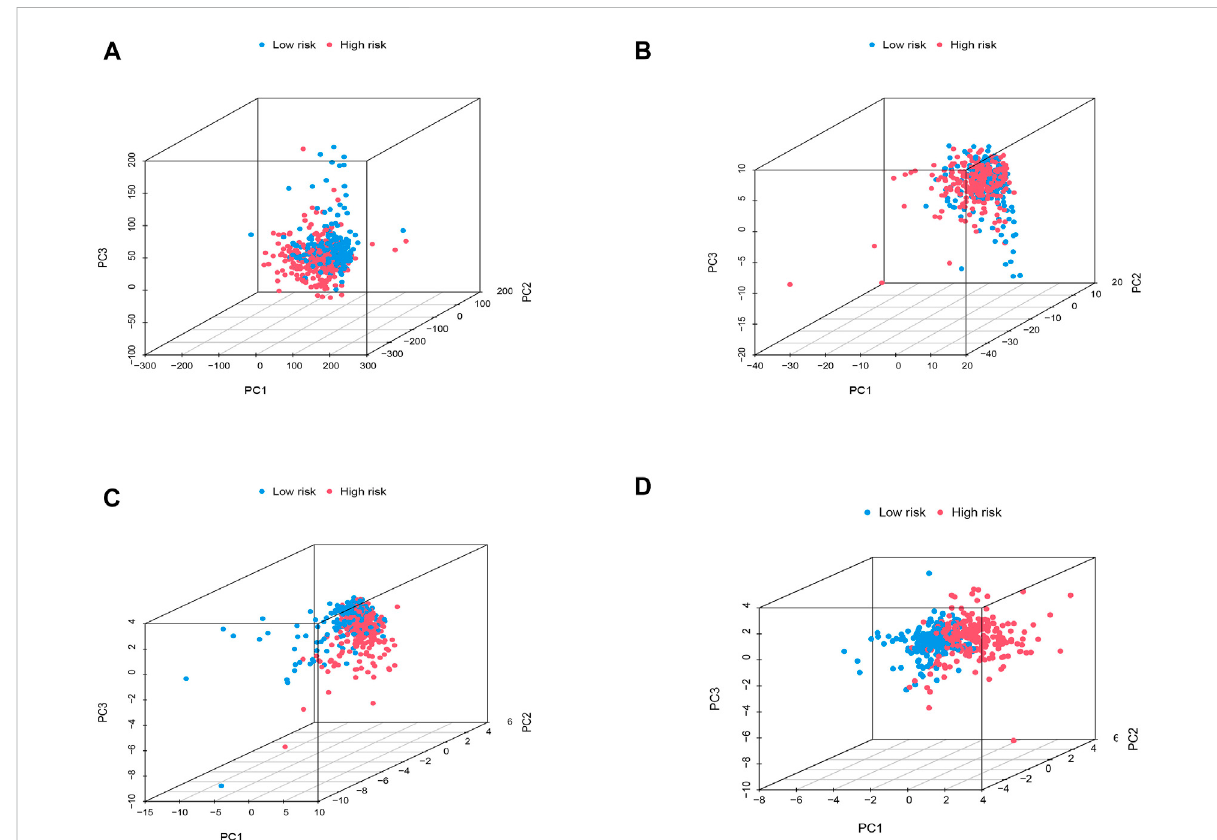
FIGURE 6 PCAanalysis. (A) Theentiresetofgeneexpressionpro fi lesinccRCCpatients. (B) 224basementmembranegenesofccRCC. (C) 33differentially expressed membrane genes of ccRCC patients. (D) Risk model based on eight BMRGs in different risk groups of